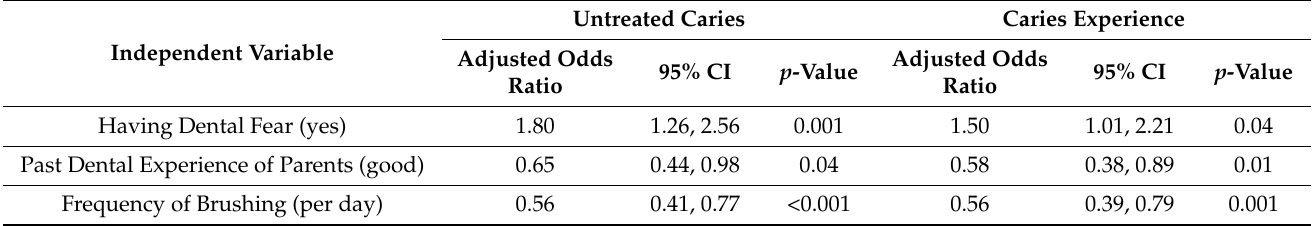
Table 5. Multivariable logistic regression models demonstrating the association between dental caries status and dental caries experience with various independent